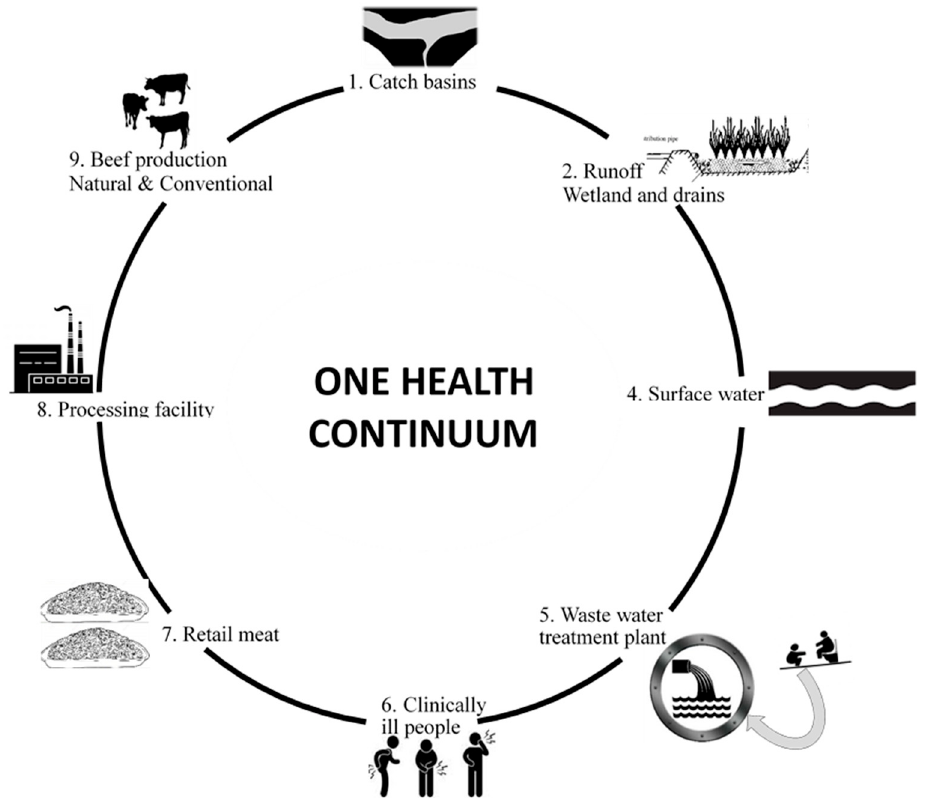
Figure 1. Details of sample type and source of Escherichia coli isolates investigated for antimicrobial resistance in a One Health study of the beef production system. Sample location/sites comprised composite fecal samples collected from penned cattle in feedlots A, B, C and D as well as water samples from catch basins. Environmental samples comprised constructed wetlands and a creek (adjacent to feedlot C). Wastewater influent and effluent were collected from two water treatment plants while samples at a beef processing facility were obtained from carcasses after hide removal, after final wash, from ground beef and retail meat. Human samples were obtained from blood, urine and abdomen samples collected from hospital patients in southern Alberta.